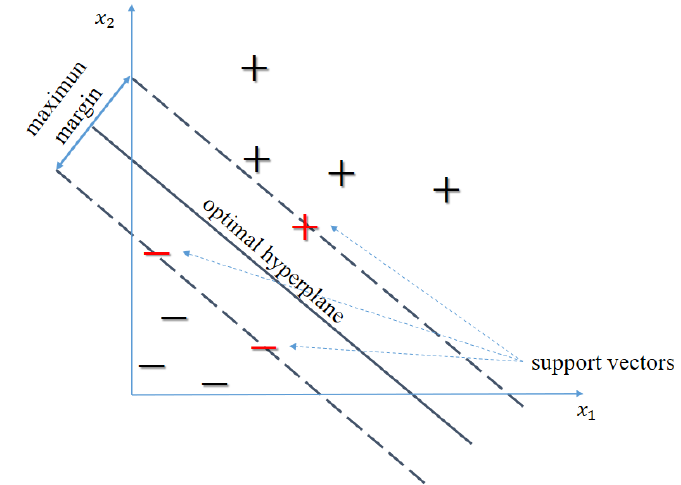
Figure 8. Linear support vector machine (SVM) in a two-dimensional